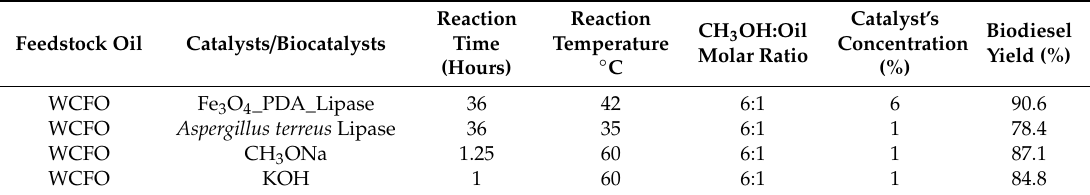
Optimized factors for biodiesel synthesis via enzymatic and chemical modes of transesterification of chicken fat